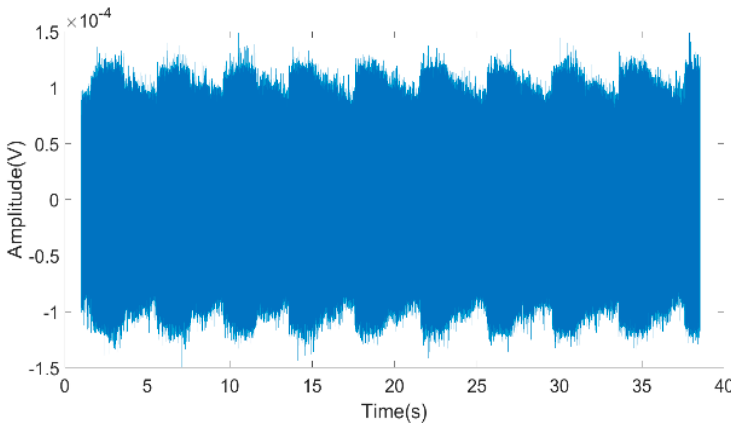
Figure 9. The output with a directional antenna.